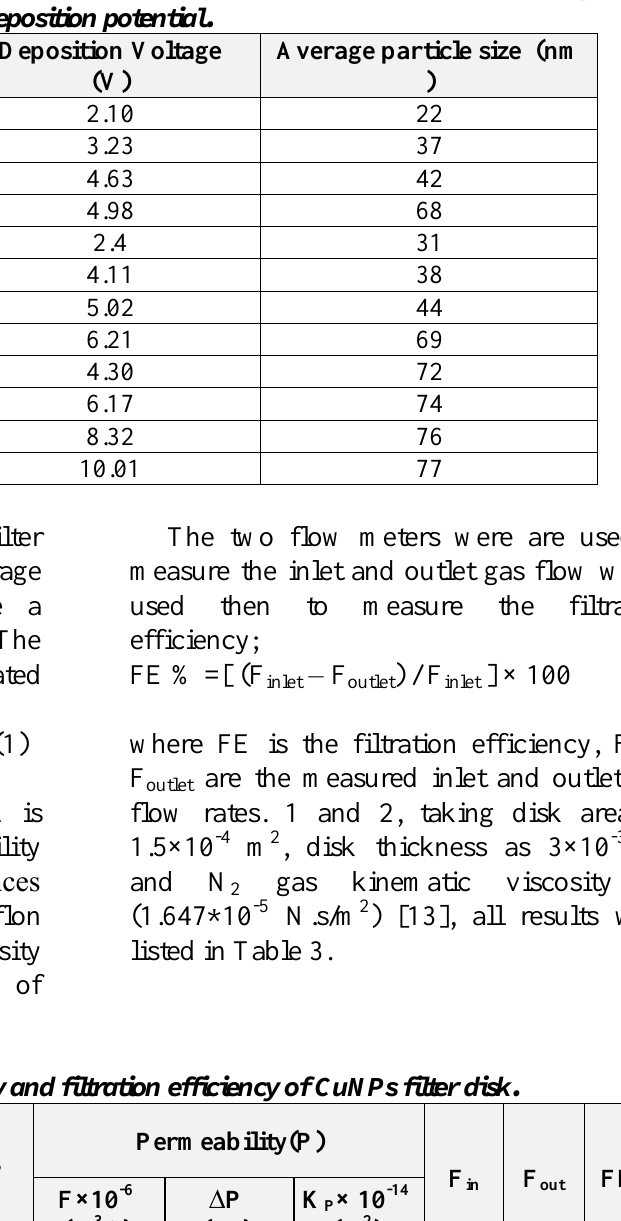
solution at different pH and 4